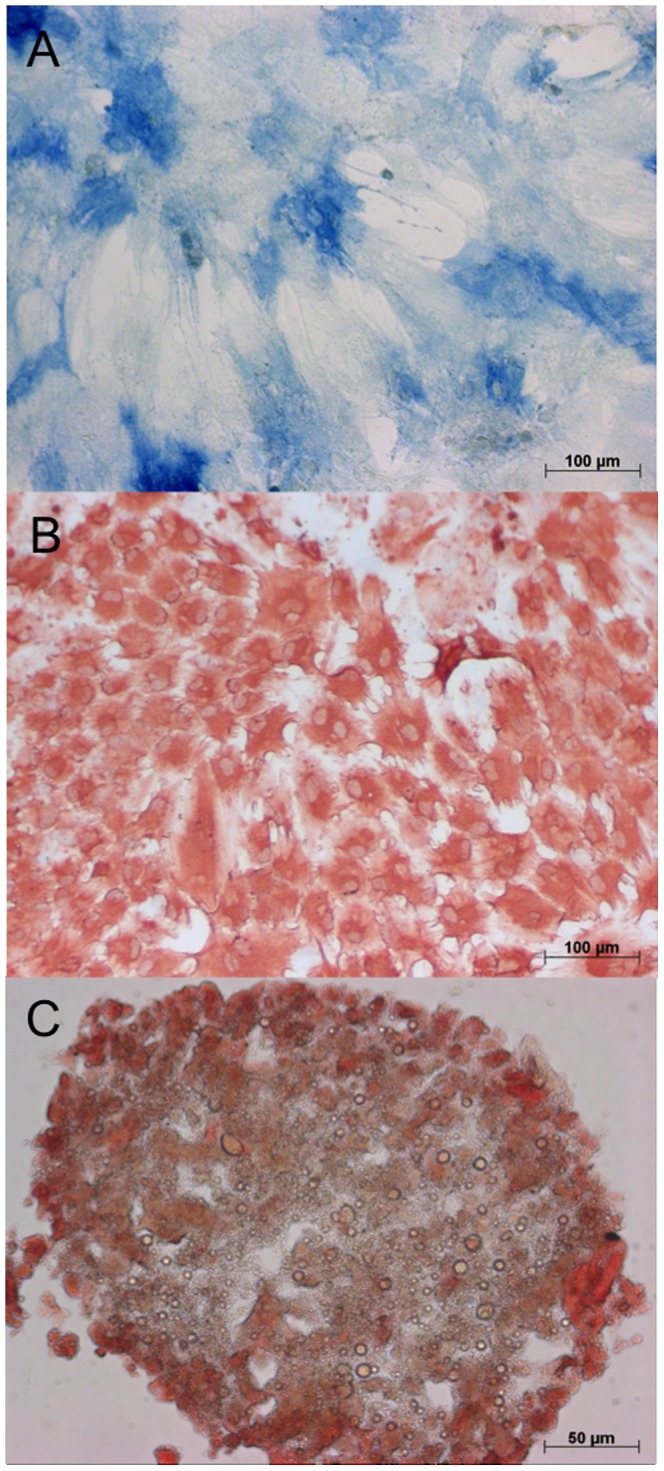
Differentiation assays on day 21.The differentiation of the mesenchymal stem cells from the bone marrow aspiration concentrate into osteoblasts became apparent by an intense blue staining for alkaline phosphatase activity (A). The adipocytes became apparent by the accumulation of lipid-rich vacuoles stained with PPAR (B) Cells cultured in chondrogenic medium showed a positive stain for chondrocyte markers over an increasing proportion of the pellet from 10 to 21 days (C).